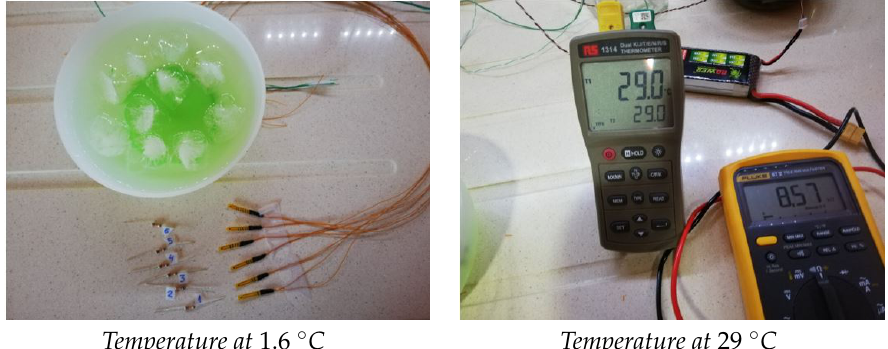
Figure 10. Calculating the parameters of the Steinhart–Hart equation. All six NTC sensors have been calibrated. The obtained values of resistance (Res i ) and temperature (Temp i ) are shown in Table